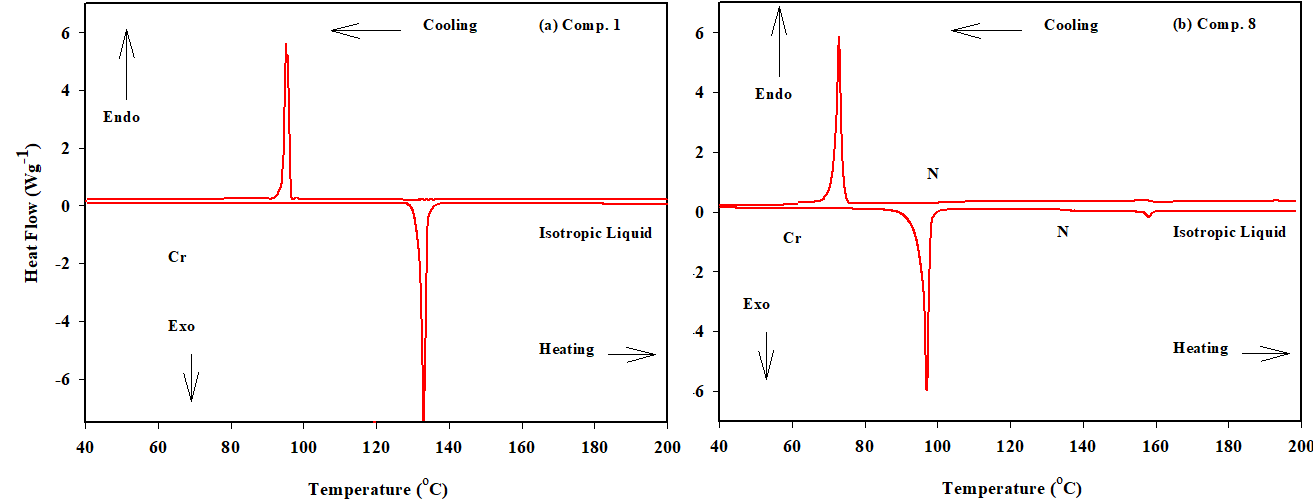
Figure 1. DSC thermograms at a heating rate of 10 °C/min of compounds ( a ) 1 and ( b ) 8 from the second heating and cooling scan.